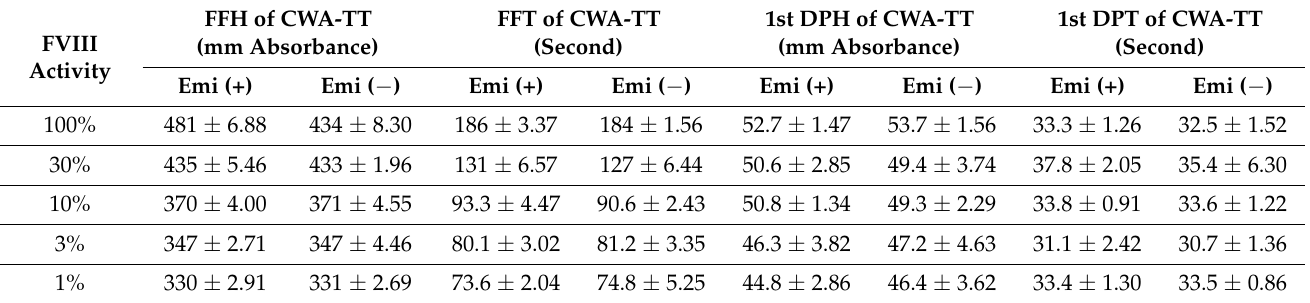
Table 2. FVIII activity and CWA-TT.